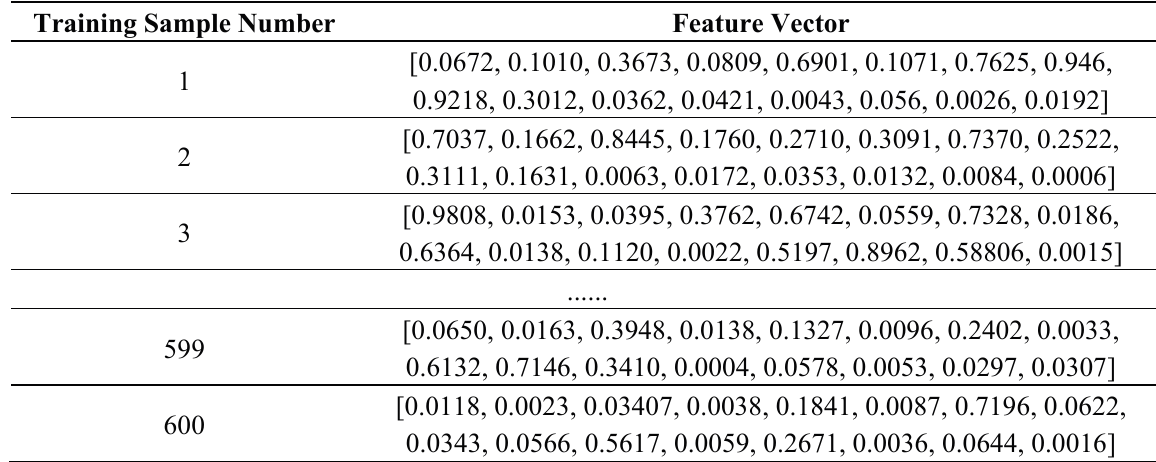
Table 2. Feature vectors of the 600 sound